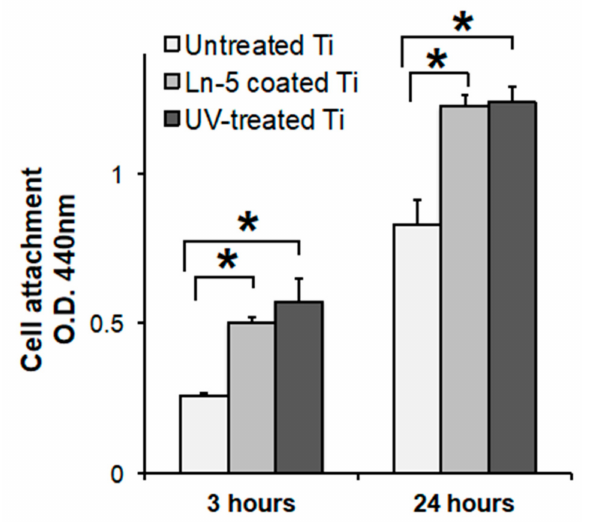
Figure 7. Initial cell attachment of human oral epithelial cells cultured on untreated control, human laminin-5 coated, and UV-treated titanium surfaces. Cell number was quantified with a colorimetric- based WST-1 assay (* p <